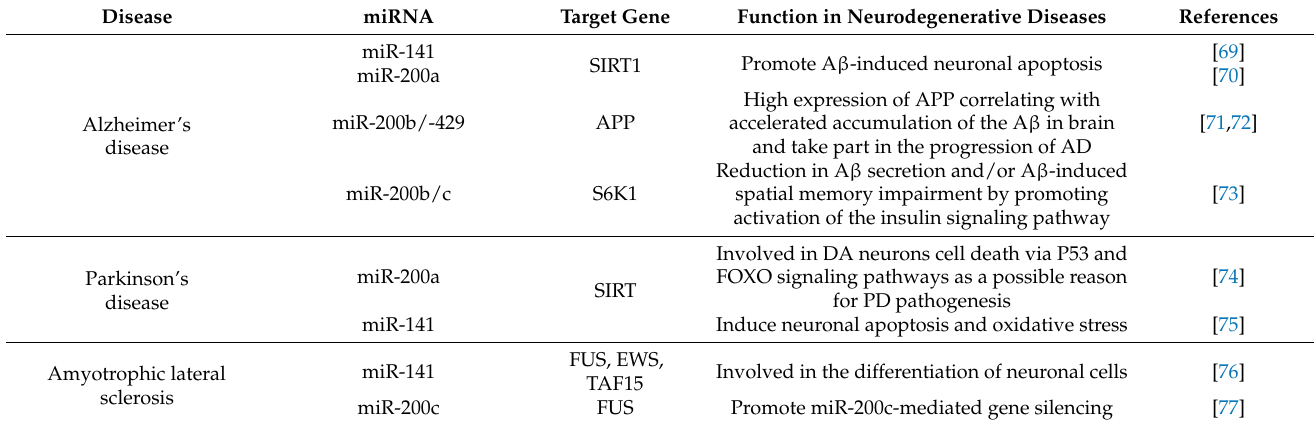
Table 2. miR-200s, target genes and their roles in neurodegenerative